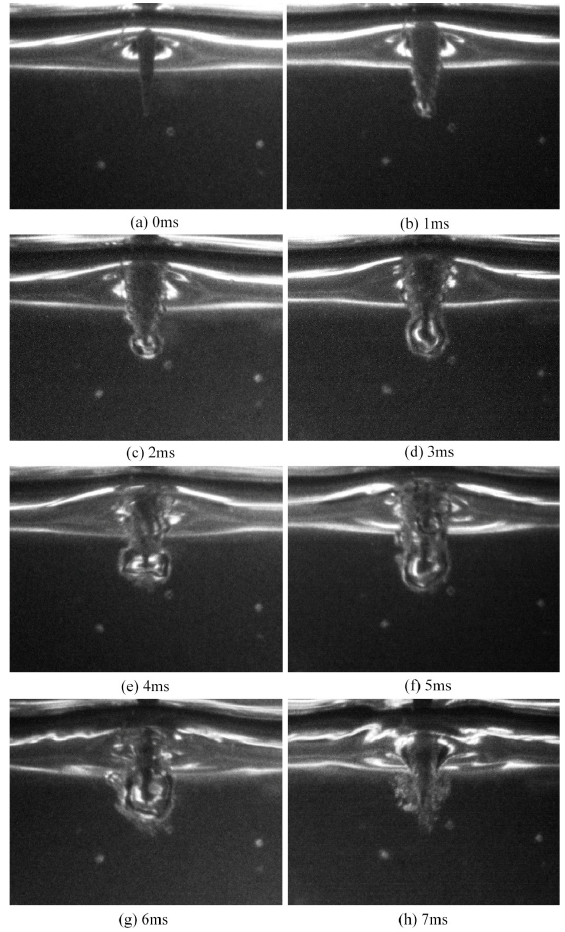
Figure 4. Images of bubbles produced around the conical electrode at different times. ( a ) 0 ms, ( b )